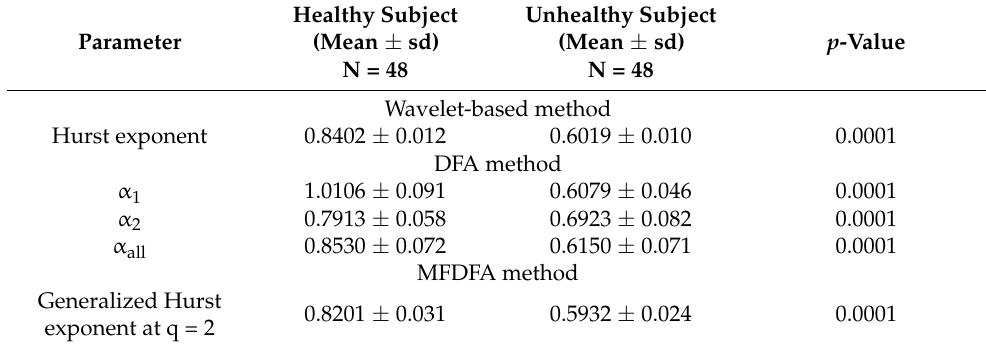
Table 3. Comparison between healthy and unhealthy